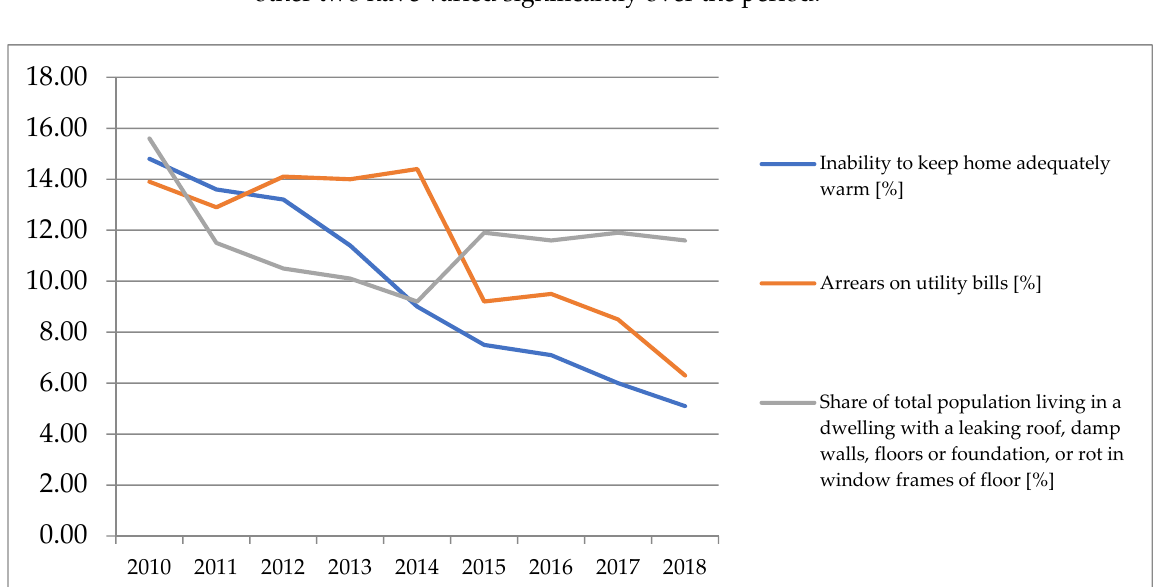
Figure 2. Selected energy poverty indicators for Poland in 2010–2018. Source: Eurostat.